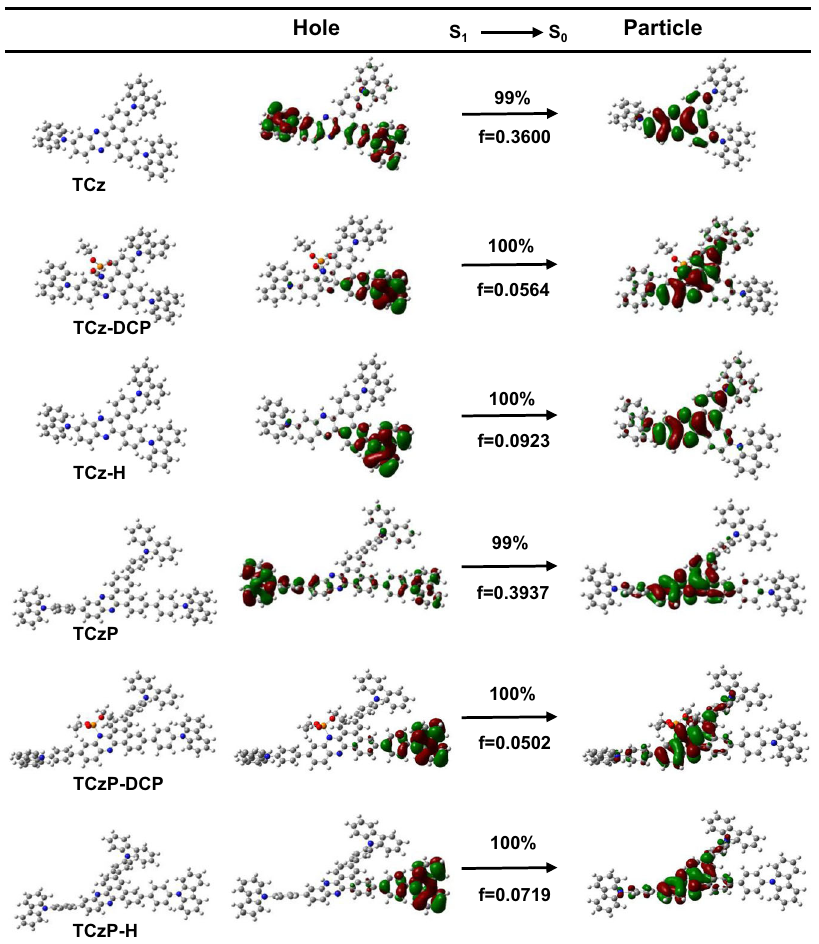
Fig. 2 | Calculated excited state properties. The NTO analysis of S 1 → S 0 transition for TCz and TCzP before and after exposure to